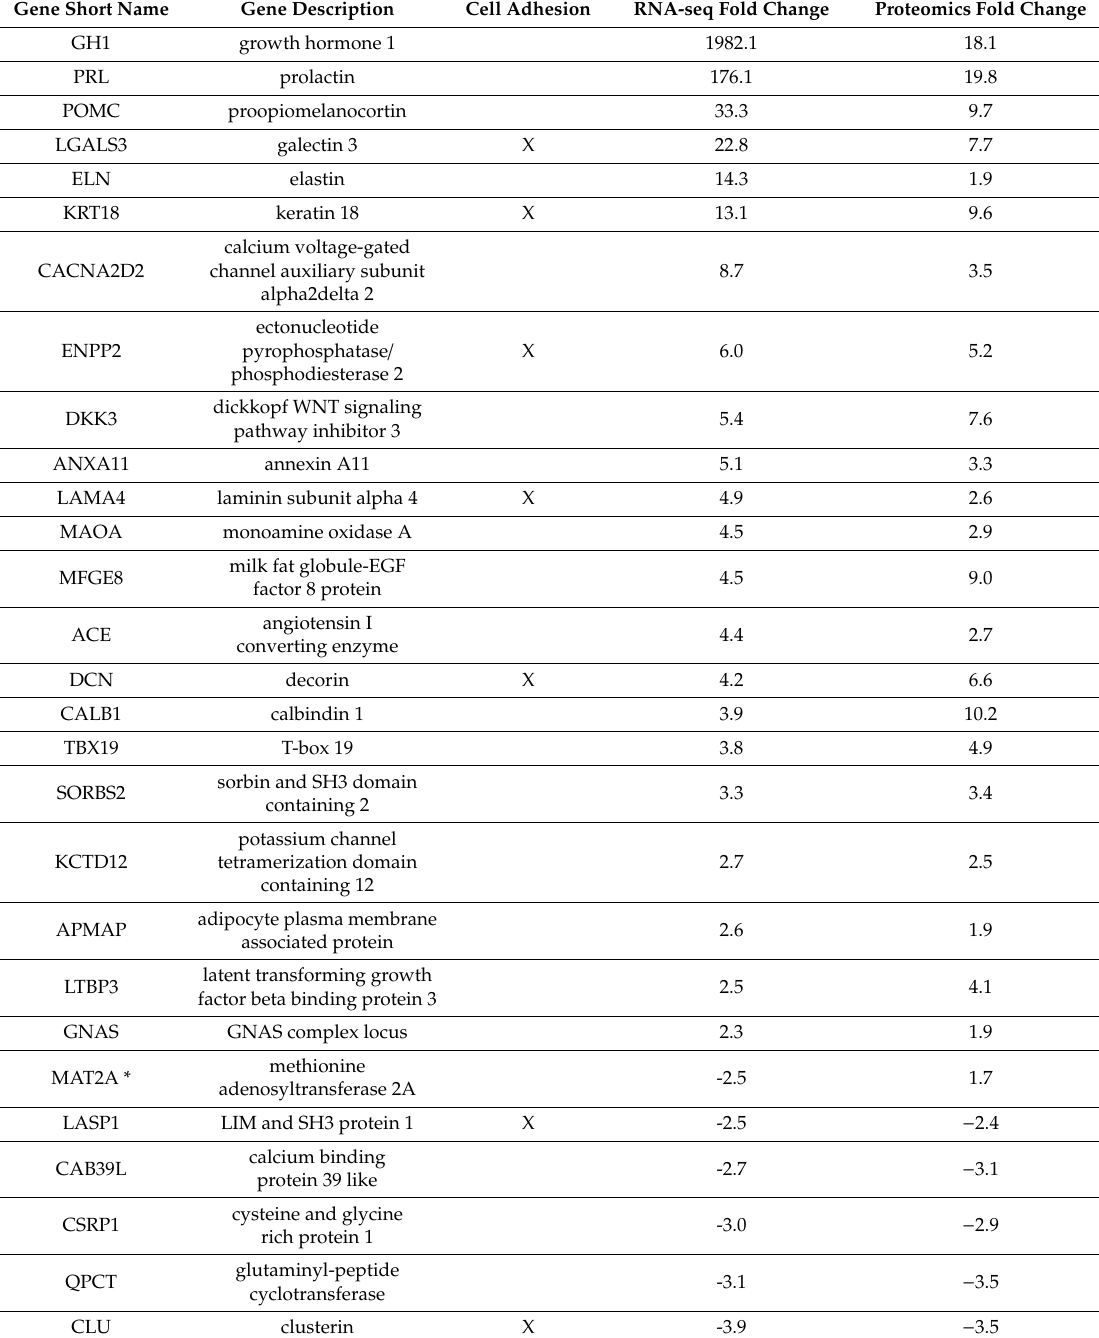
Table 1. Common molecules presented in transcriptomics and proteomics studies. Thirty-eight molecules were di ff erentially expressed at both mRNA and protein level in functioning (FCA) and silent (SCA) corticotroph adenomas. Molecules up-regulated in FCA are presented with positive fold of change